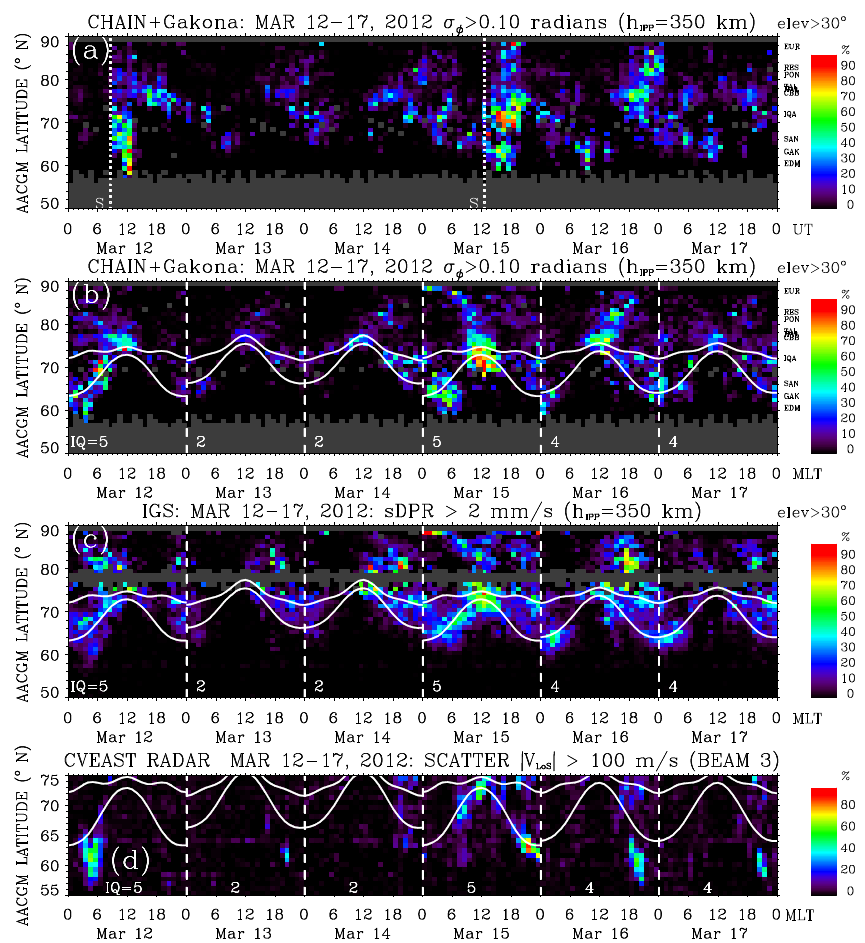
Figure 4. Same as Fig. 3 but for the time interval from 12 to 17